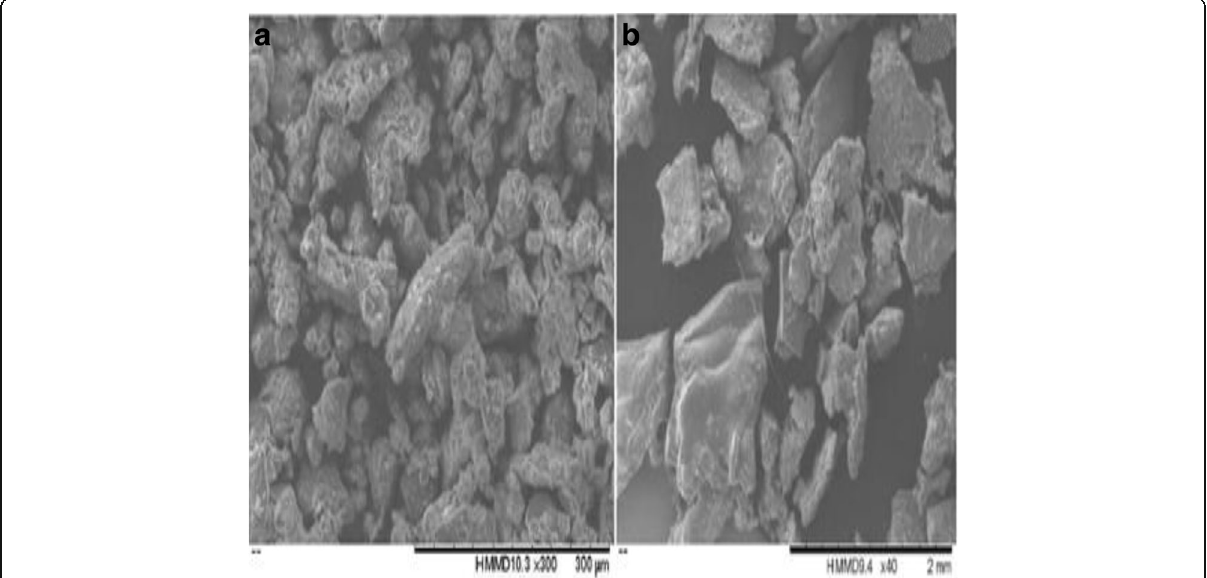
Fig. 7 a SEM-image for pre-extraction ( b ) SEM-image for